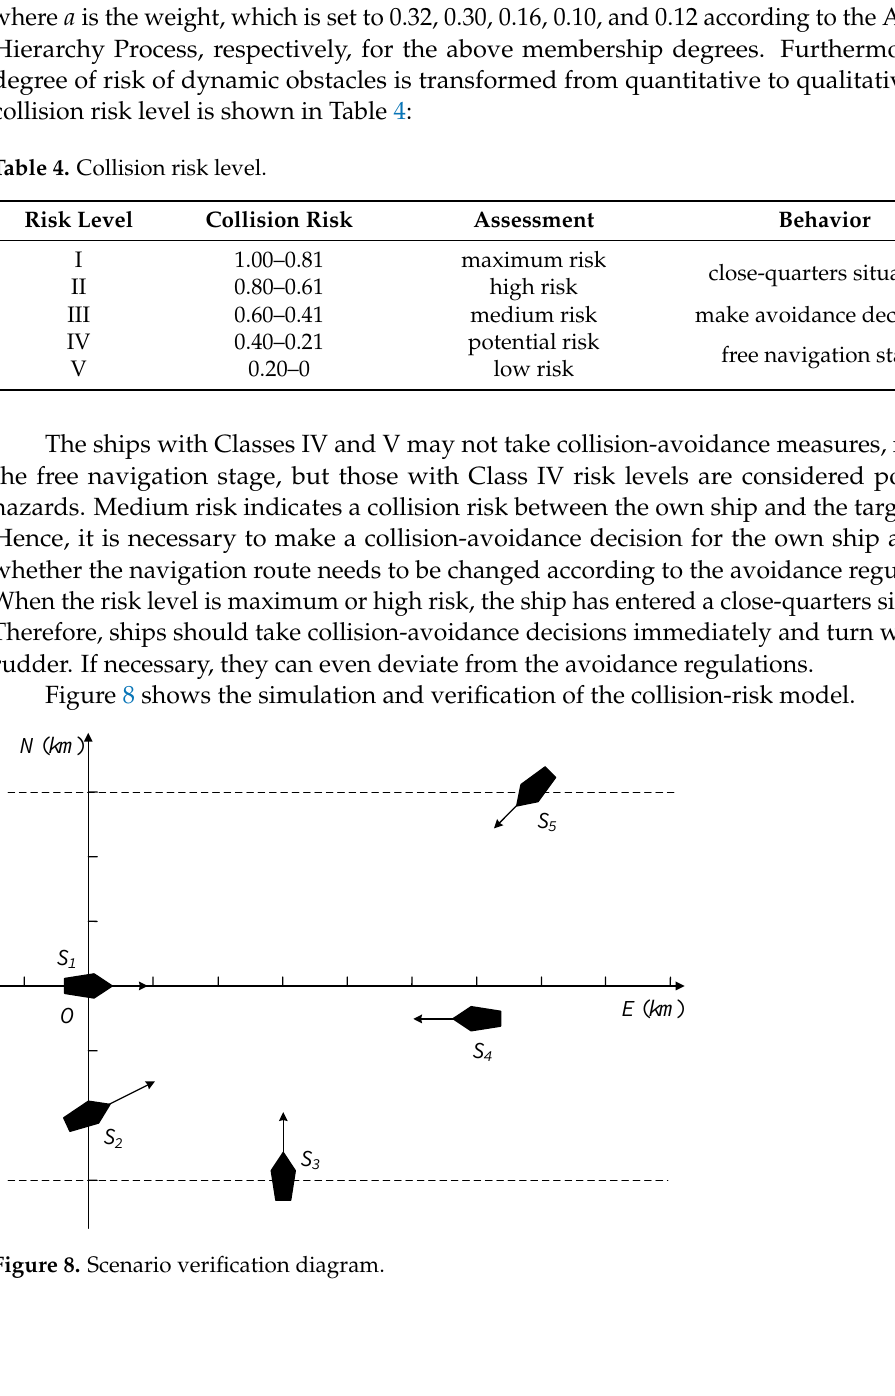
Table 5. Collision risk level. No.